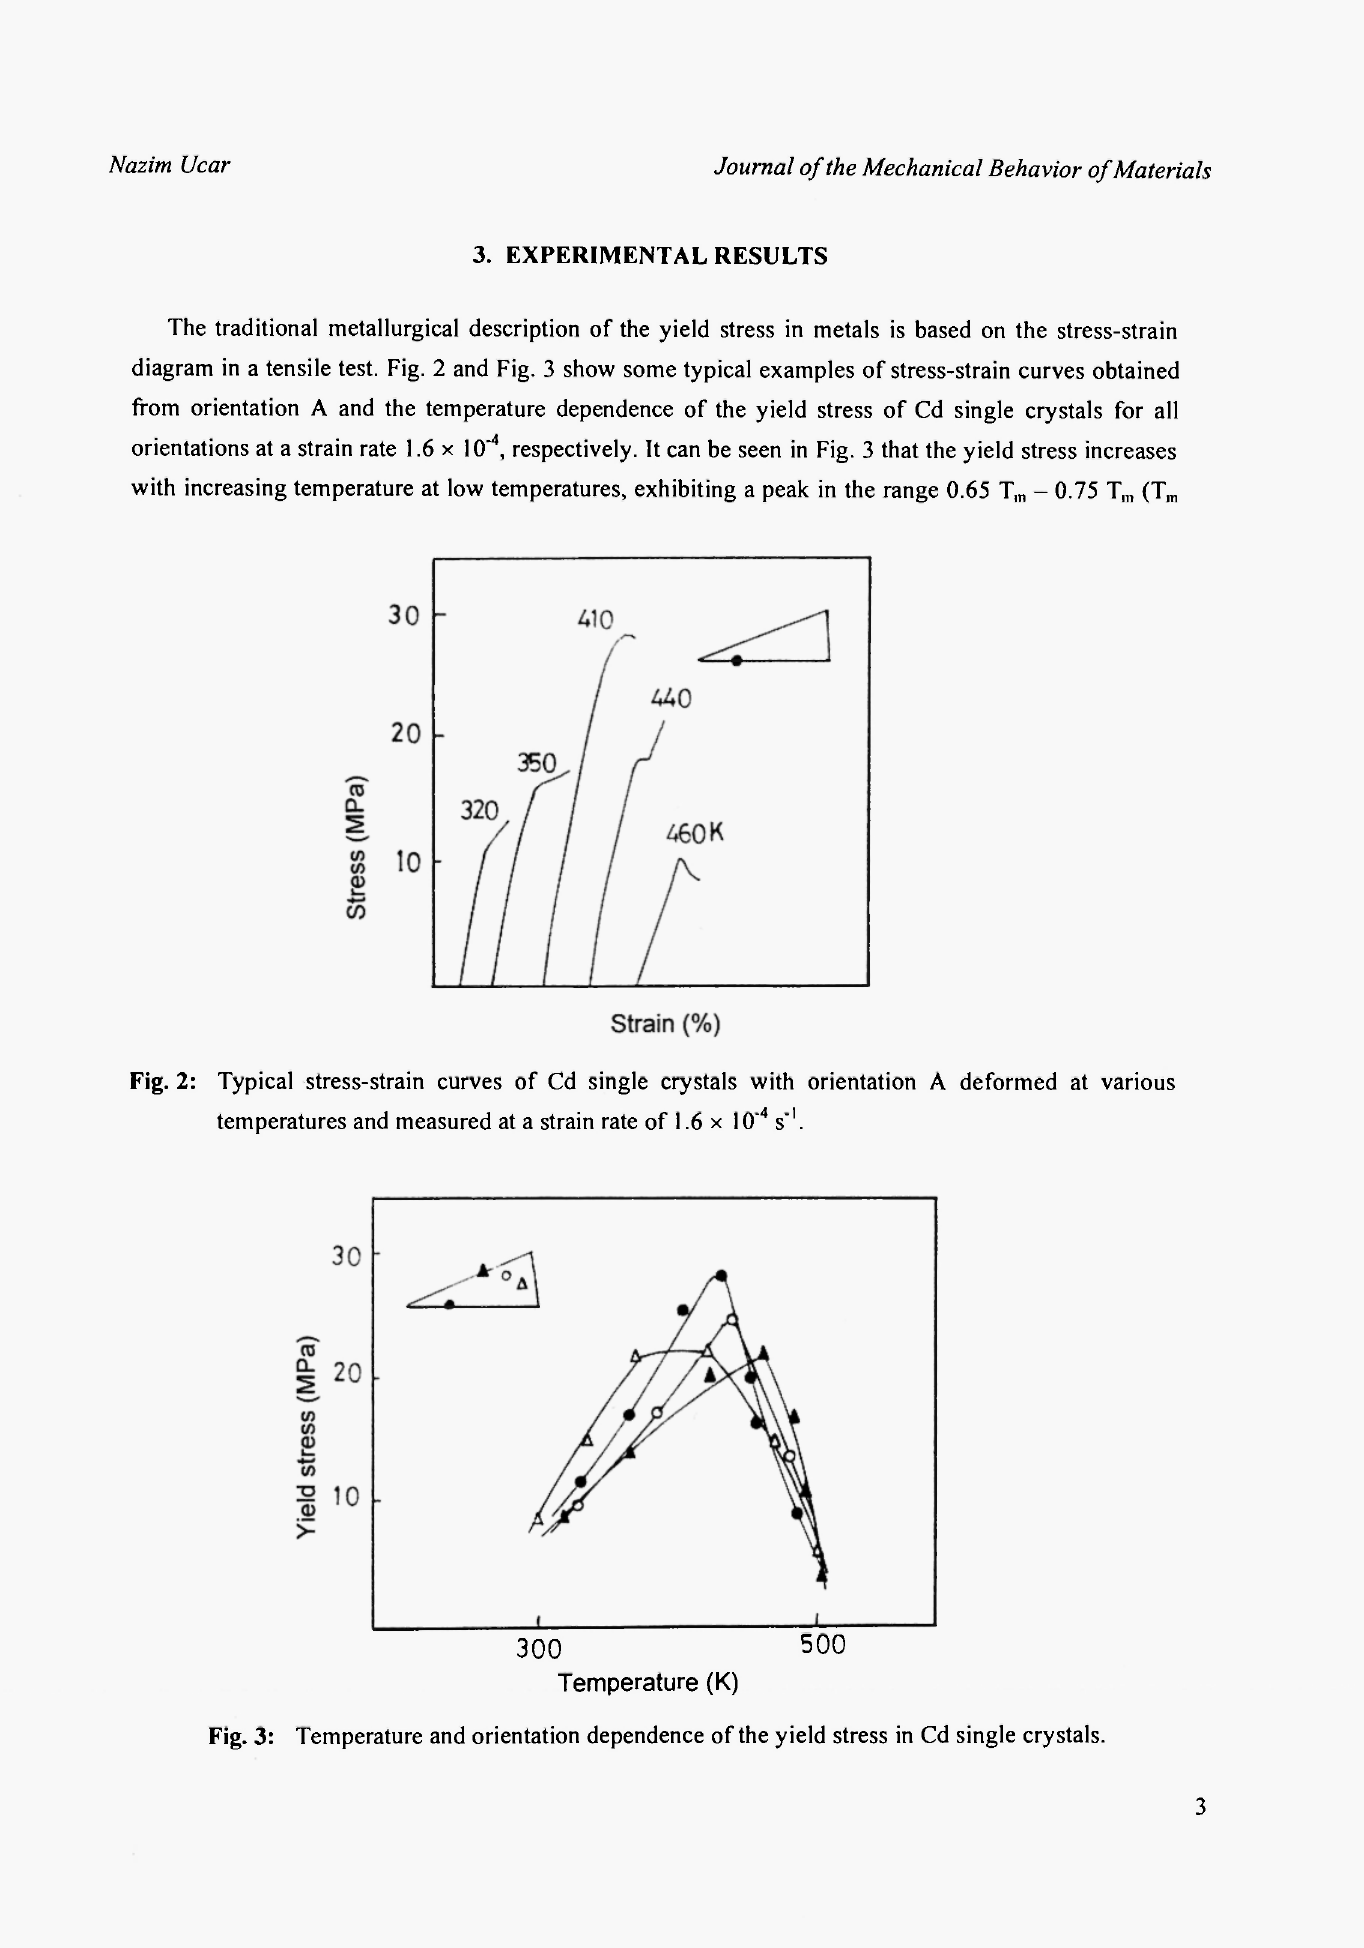
Fig. 3: Temperature and orientation dependence of the yield stress in Cd single